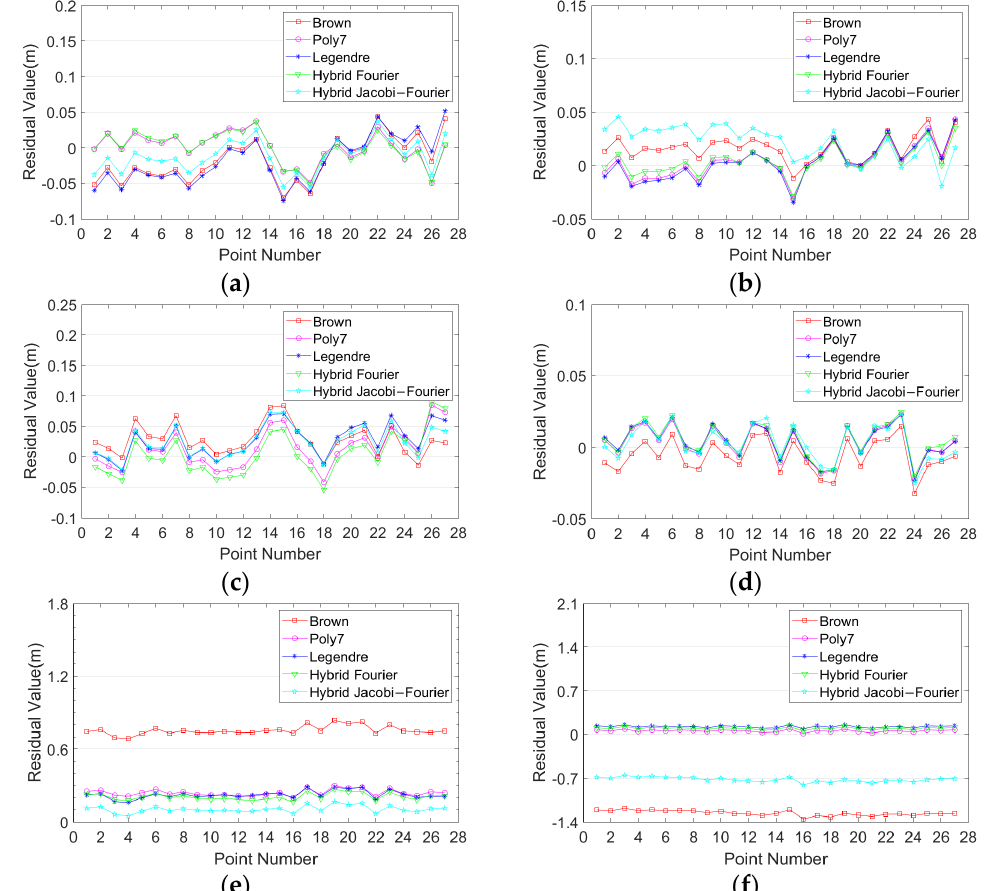
Figure 7. The residuals of check points after self-calibration for test site 1. ( a , c , e ) The residuals of check points of the rectangle dataset in the direction of X, Y, and Z, respectively; ( b , d , f ) the residu- als of check points of the S-shaped dataset in the direction of X, Y, and Z, respectively.